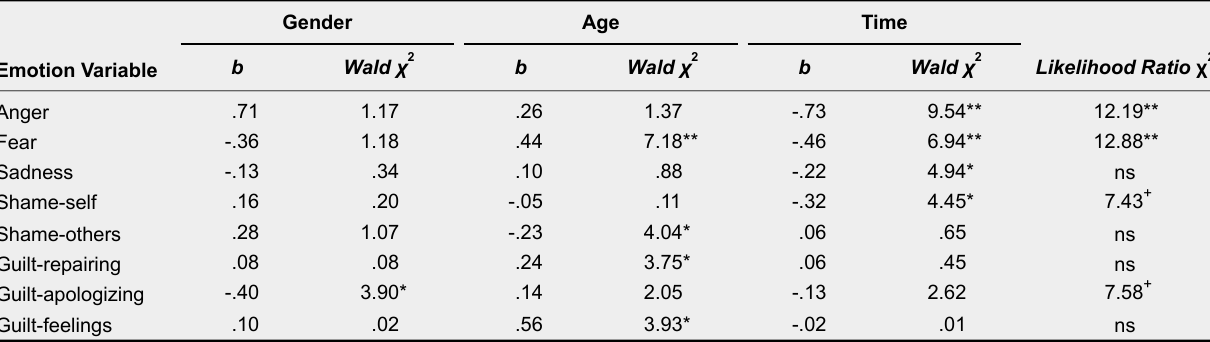
Coefficient Estimates from Poisson Regressions and Associated Significance Tests for Effects of Child Gender, Child Age, and Time Child Spends with Parents on Basic Negative Emotions and Self-Conscious Emotions in the Narrative Story Stem Technique (N = 38)